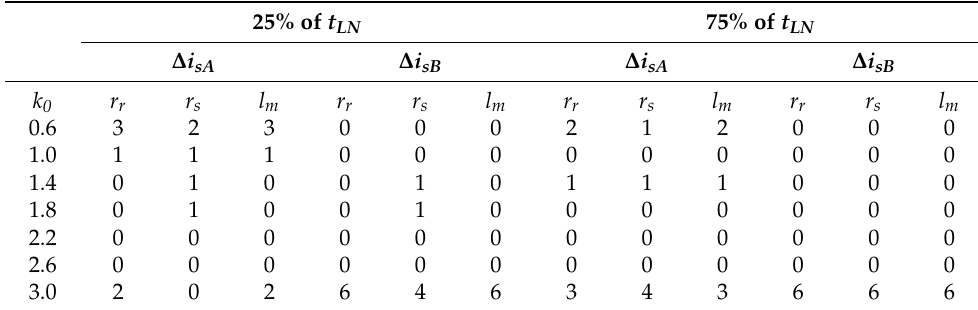
Table 3. The number of smallest RMSE values for individual k 0 .